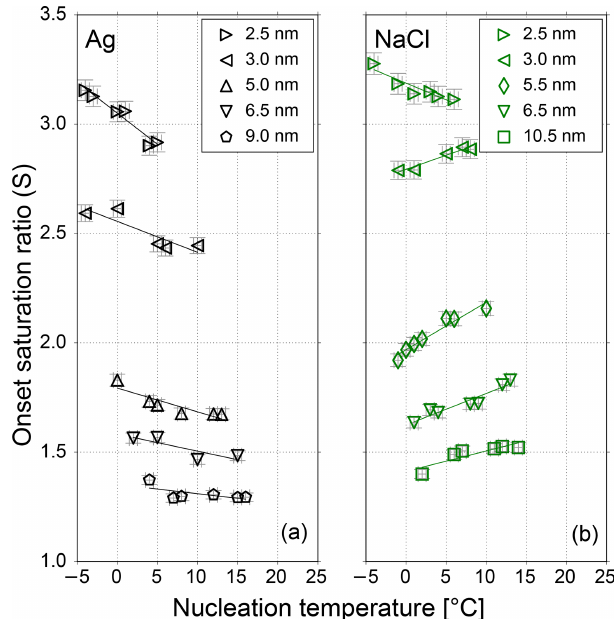
Figure 2. The onset saturation ratio versus nucleation temperature for neutral Ag (black) and NaCl (green) particles of different mo- bility equivalent diameters. With decreasing temperature the onset saturation ratio decreases for sodium chloride and increases for sil- ver nanometer-sized particles. Only the 2.5nm NaCl seeds do not follow the opposite temperature trend. Lines represent a linear fit of data to show the temperature dependence for NaCl and Ag seeds. The onset saturation ratio increases with decreasing seed size for both test